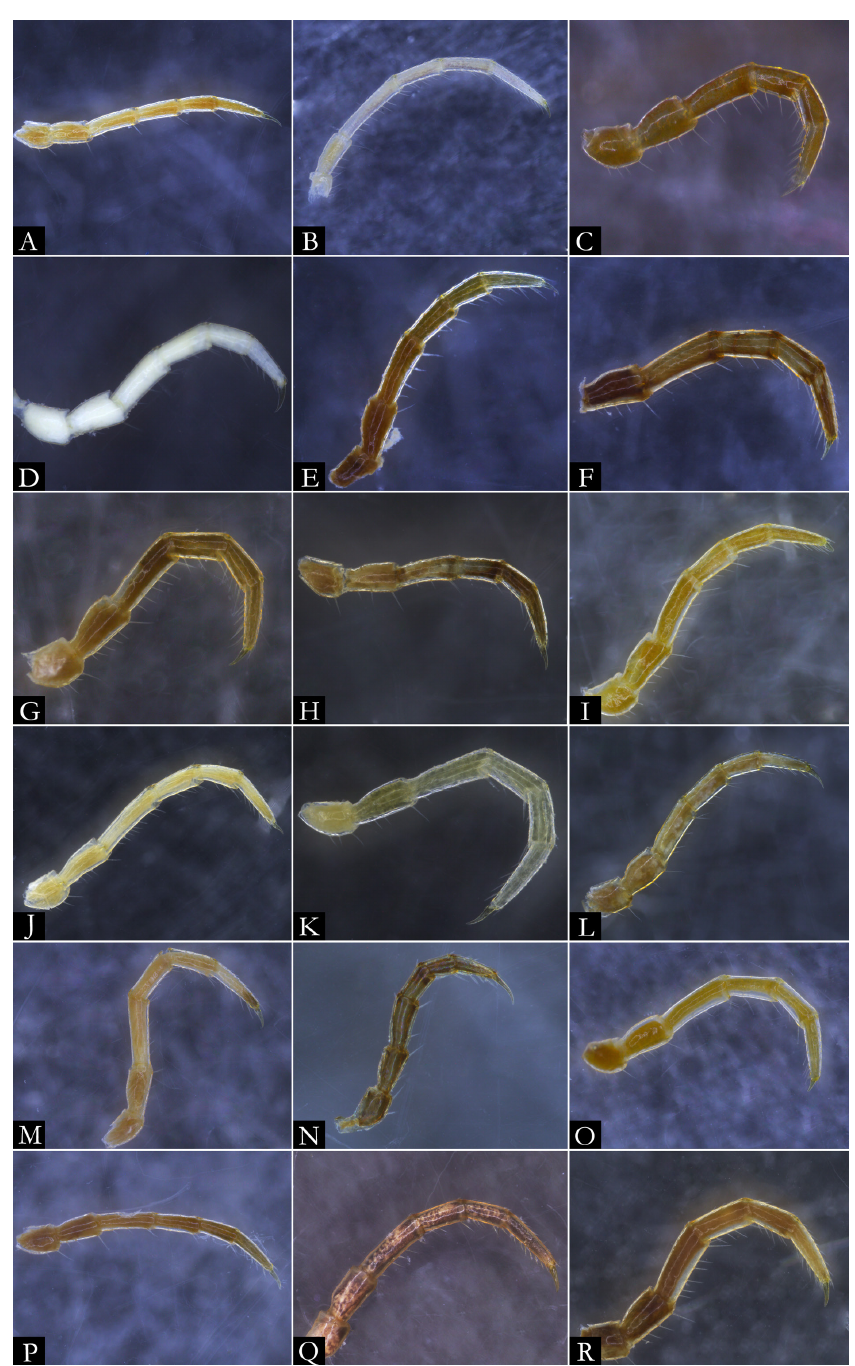
Fig. 165. Stereoscopic images of midbody legs of species of Pseudonannolene Silvestri,